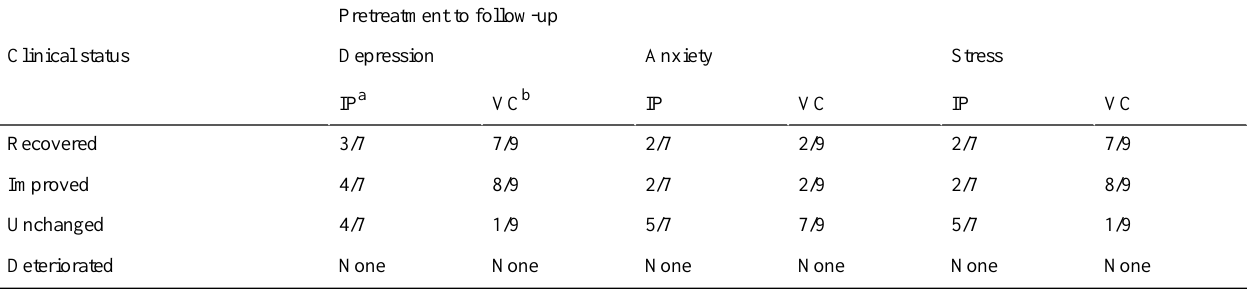
Table 5. Rates of clinical improvement from pretreatment to follow-up for the DASS. Pretreatment to